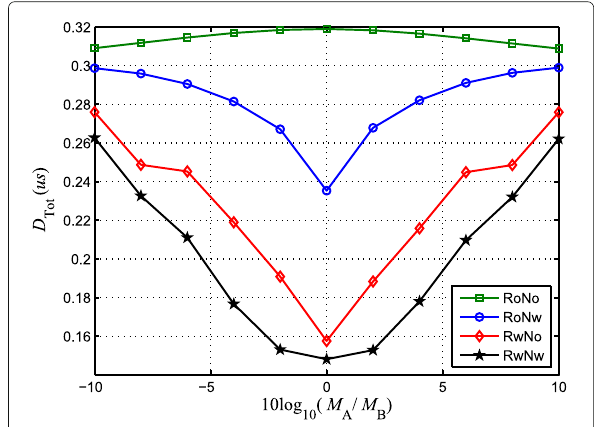
Fig. 11 D II performance comparison of the four schemes in Example 2, where h A = [1 2 2 3 4 5 5 6 6] and h B = [6 6 6 5 4 4 3 2 1